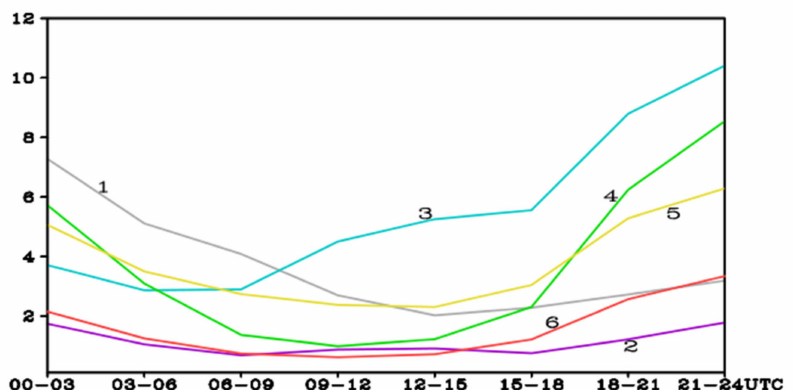
Figure 13. The mean diurnal cycle of the CMORPH estimated rainfall (mm/day) in the rectangular area of 80.7–82.7 ◦ W, 32.4–34.4 ◦ N, over the Savannah River basin. WTs 1–6 are gray, purple, light blue, green, yellow, and red, respectively, also noted by the numbers 1–6.